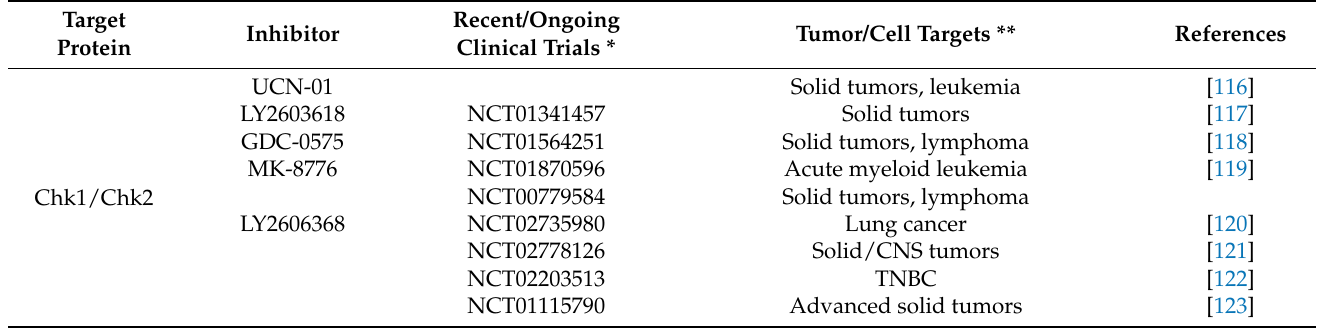
Table 1. Replication stress targets in preclinical development and clinical trials.